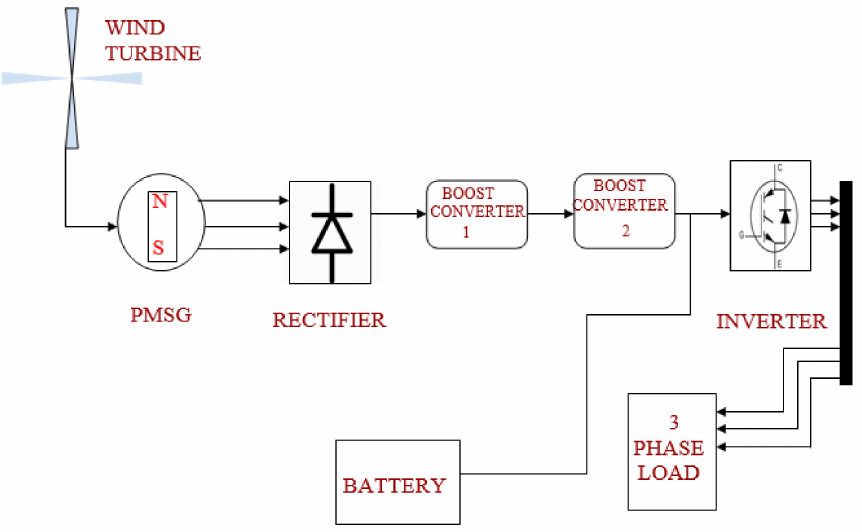
Figure 9. Permanent magnet synchronous generator (PMSG)-based wind energy conversion system (WECS).